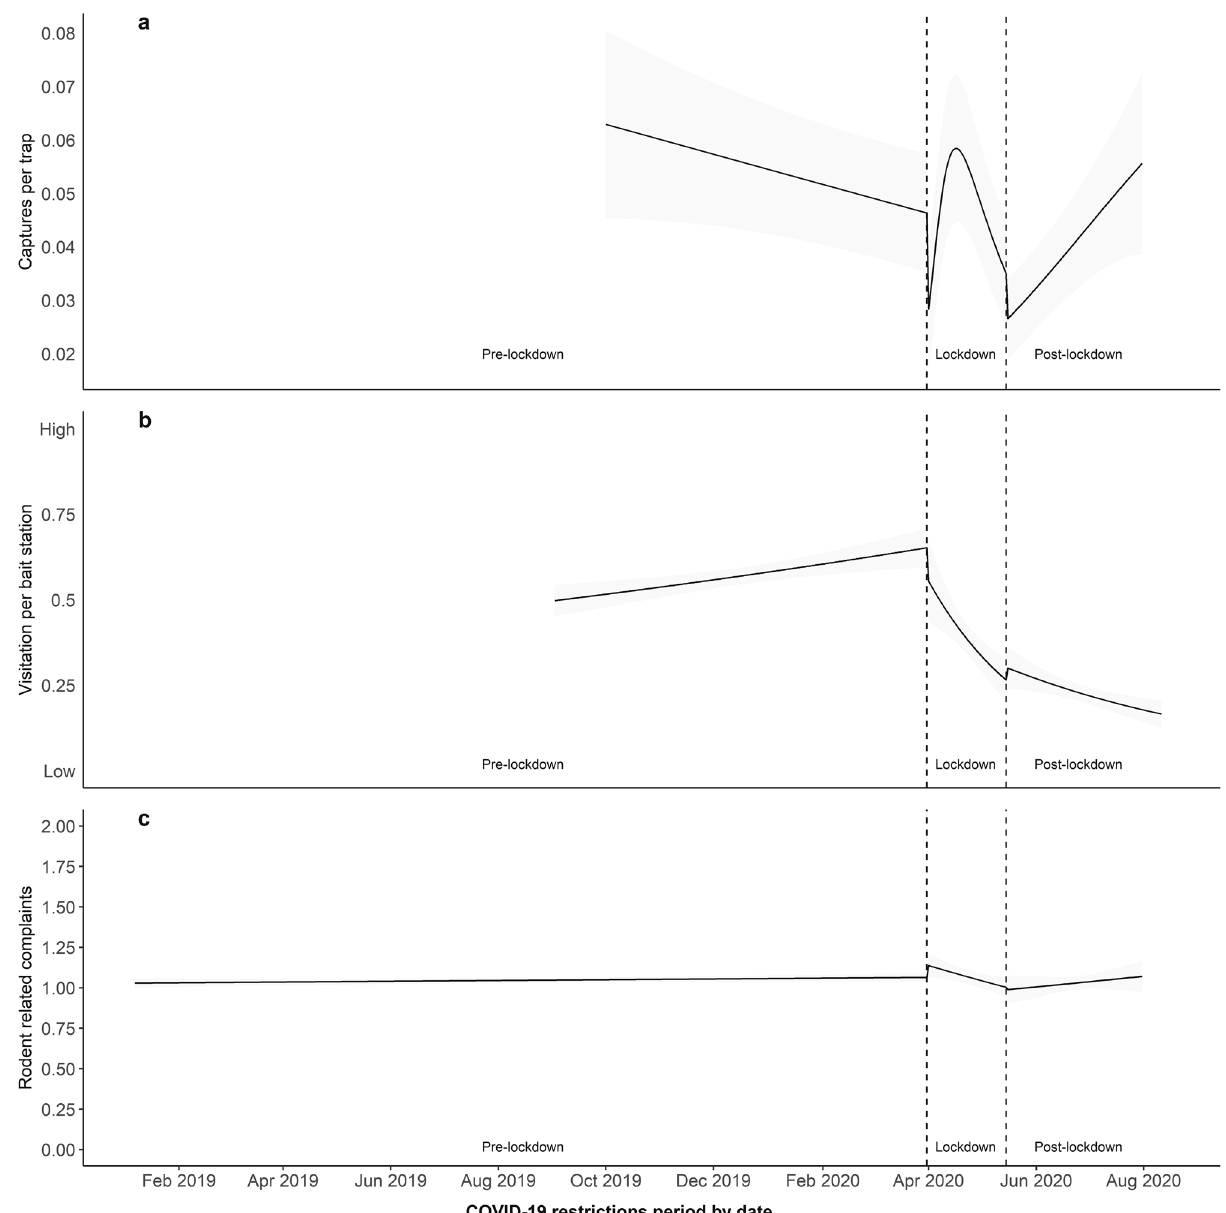
Figure 2. Estimated rodent captures per trap ( a ), rodent visitation per bait station ( b ), and rodent related complaints ( c ), received by the Council of the City of Sydney over time. The shaded grey area represents the standard error of the mean (SE). Dashed vertical lines represent the start and end points of COVID-19 restrictions and social distancing measures imposed by the New South Wales State